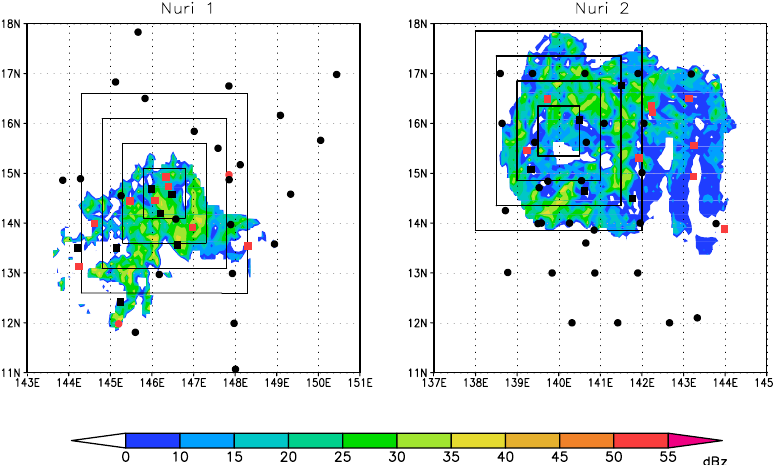
Figure 1. Electra-Doppler Radar reflectivity composite (in dBZ) at 3km altitude for Nuri 1 (left) and Nuri 2 (right) superimposed with dropwindsonde locations. The dropwindsondes from the USAF C130 (filled circles) and NRL P3 (filled squares) have been translated to their 00:00UTC positions using a (westward) phase speed of − 7ms − 1 . The red circles and boxes indicate dropwindsondes with no retrieved wind data. The square boxes are at one-degree increments, increasing from one degree to four degrees, and represent the domain used in several of the forthcoming analyses. The boxes are centered on the sweet spot position at 1.5km altitude within the pre-Nuri wave as derived from the 25km SAMURAI analyses. The abscissa is longitude and the ordinate is latitude.